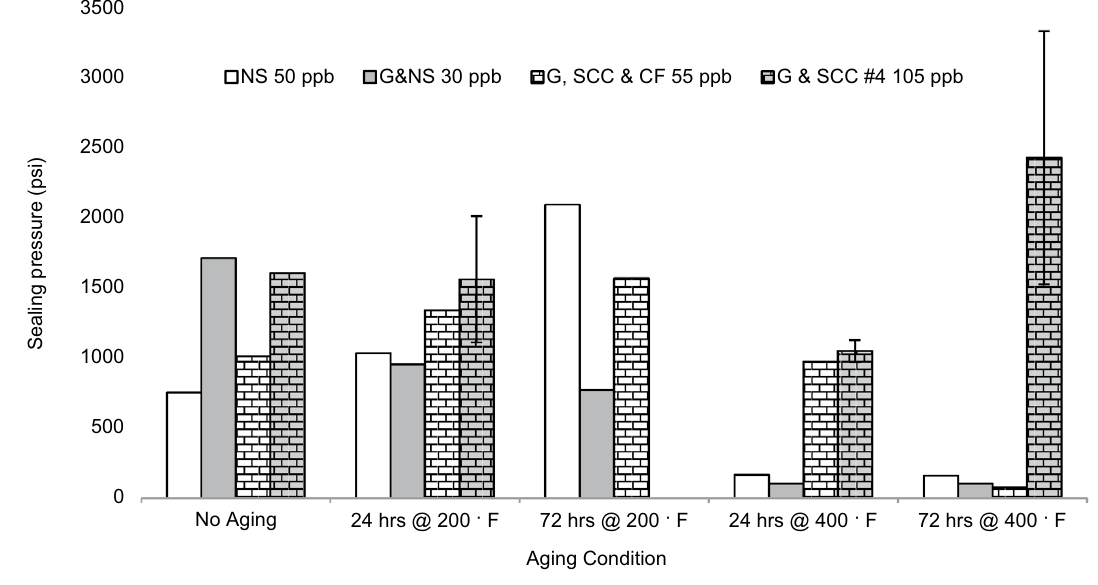
Fig. 7 Sealing pressure of the drilling fluids treated with different LCM after subjected to different aging